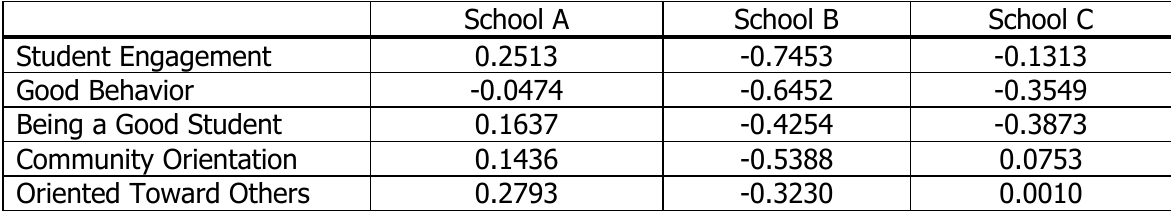
Comparing Levels of 5th Grade Student Outcomes in Spring: Three